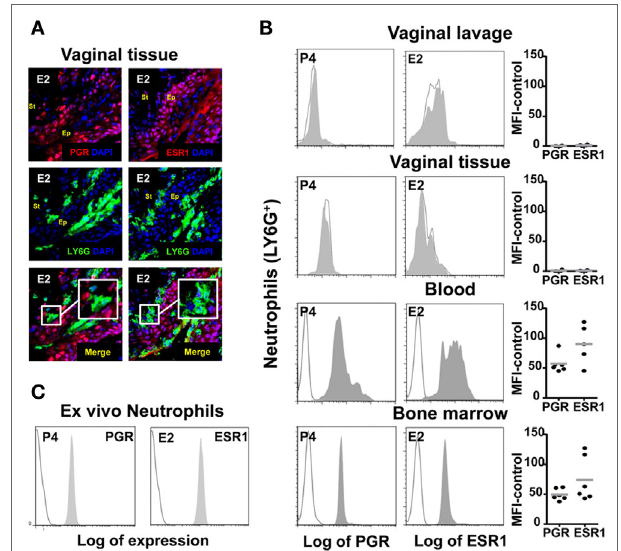
FigUre 5 | Hormone-treated ovariectomized mice were Candida albicans inoculated in the vagina. (a) Representative pictures of sections assayed for LY6G + (green) and estradiol nuclear receptor ESR1 (red) or progesterone nuclear receptor PGR (red). (B) Representative flow cytometry plots neutrophils (LY6G + ) assayed for ESR1 and PGR expression from vaginal lavage, lower female reproductive tract, blood, and bone marrow cells from hormone-treated mice. Each circle represents a mouse. (c) Bone marrow neutrophils were isolated and ex vivo hormone-treated for 12 h and assayed for ESR1 and PGR expression. A representative experiment of three independent tests is shown. Isotype control mAb (line) and indicated mAb (gray filled lines). Abbreviations: E2, estradiol; P4, progesterone; Ep, epithelium; St, stroma.